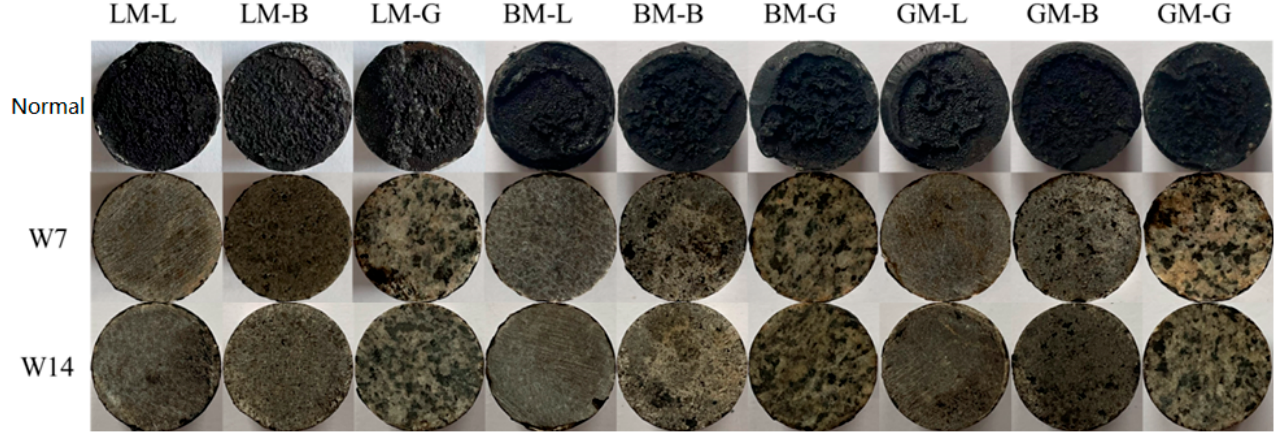
Figure 13. Failure of asphalt mastic–aggregate interface under water immersion.